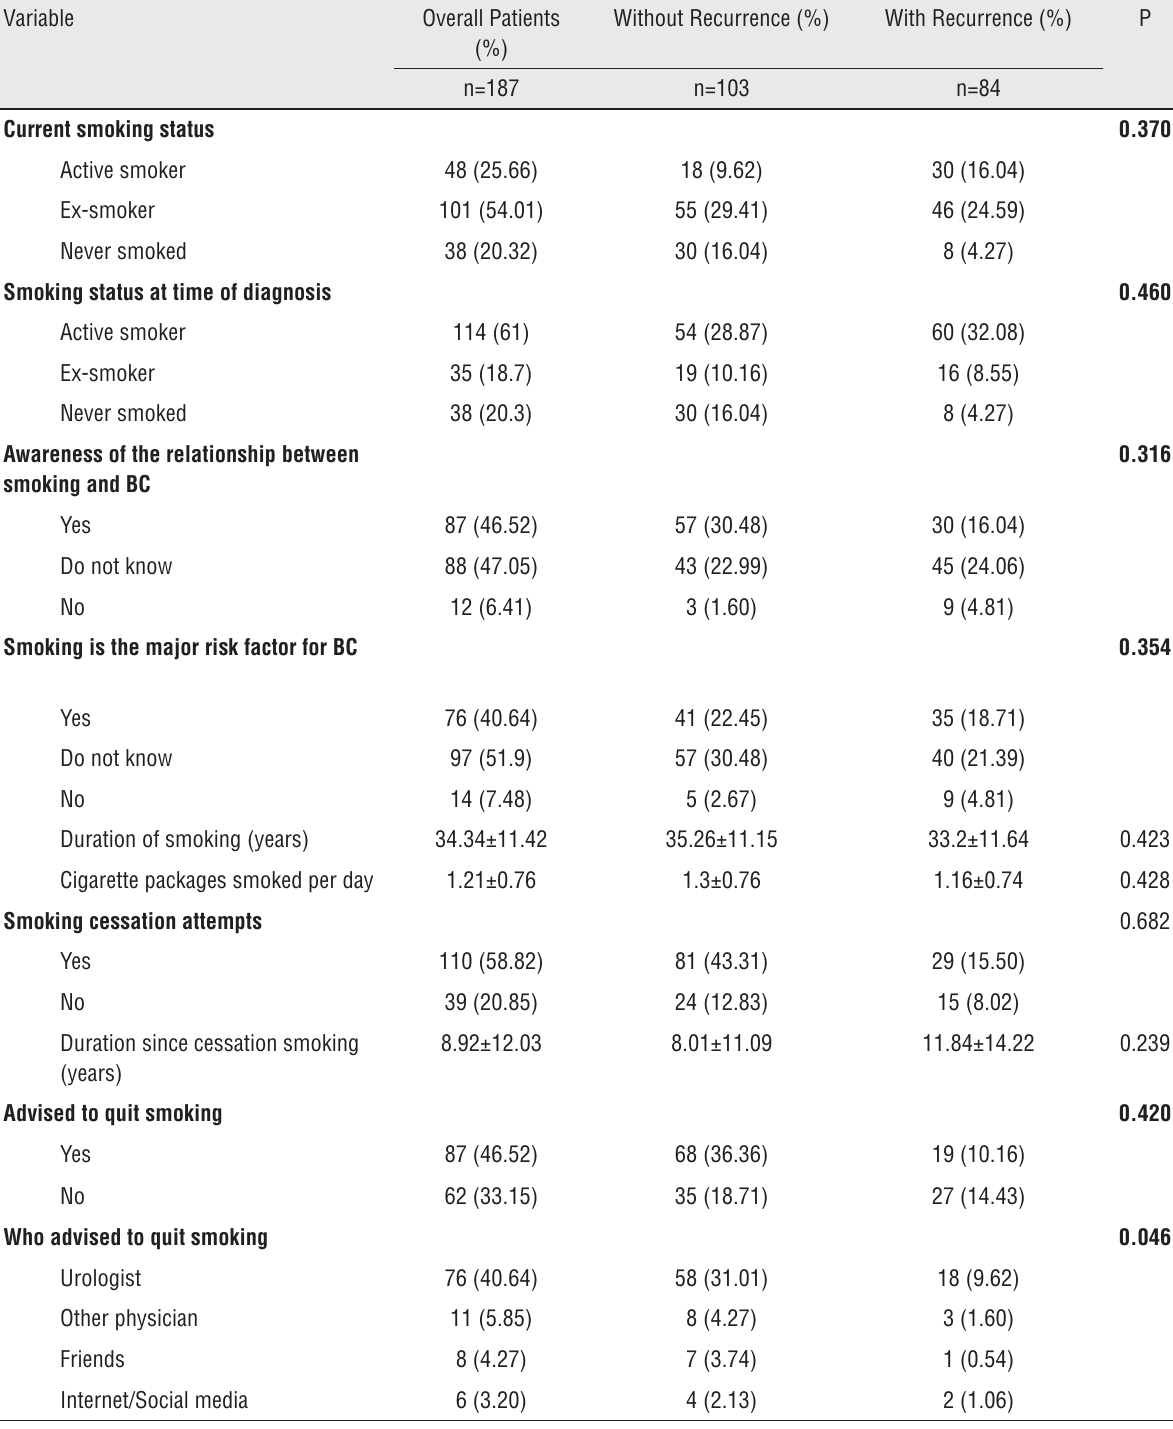
Table 2 - smoking habits, awareness of the relationship between smoking and bladder cancer and their relationship with the recurrence of the